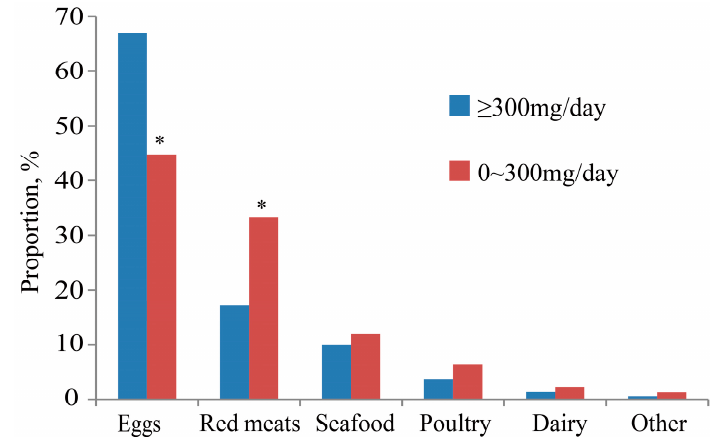
Figure 2. Food sources of dietary cholesterol by levels of cholesterol intake. *: Compared with the group of ≥ 300 mg/day, p < 0.001.